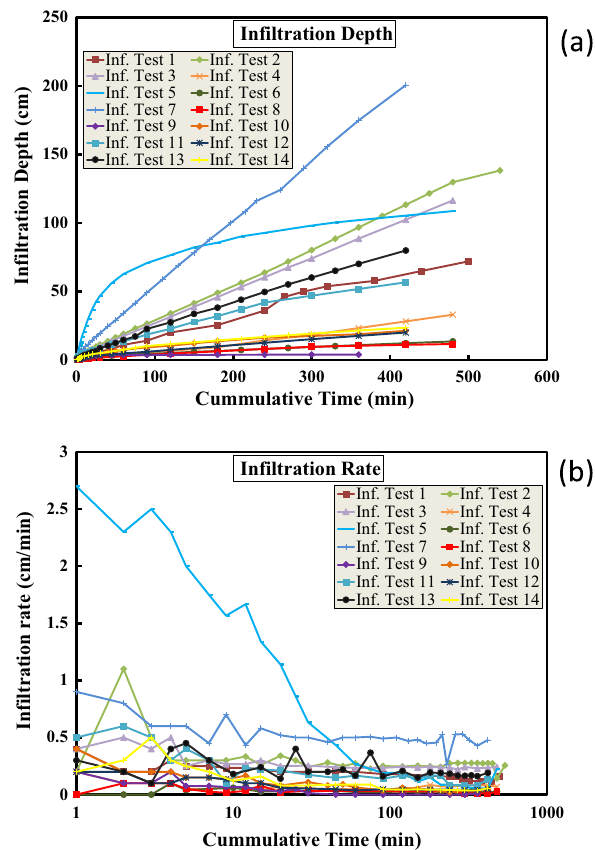
Fig. 6 Infiltration test data. a Cumulative infiltration depth, b infiltra- tion